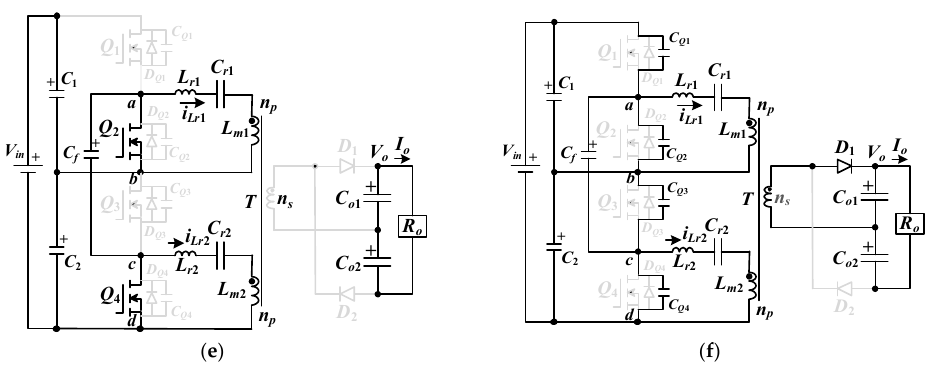
Figure 5. Equivalent circuits ( a ) mode 1; ( b ) mode 2; ( c ) mode 3; ( d ) mode 4; ( e ) mode 5; ( f ) mode 6.